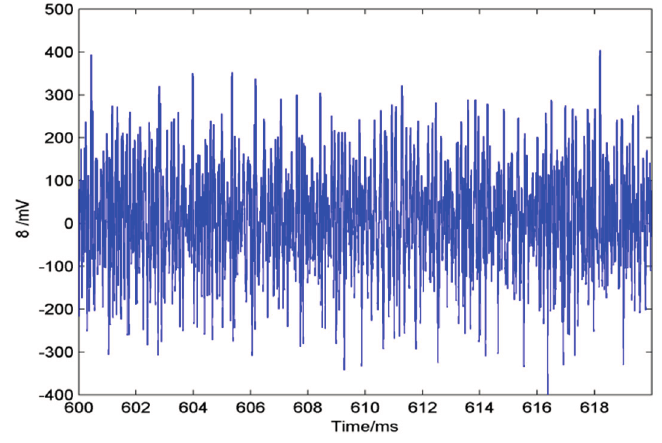
Figure 11. Acquired single-sensor signal (the time length is 0.01